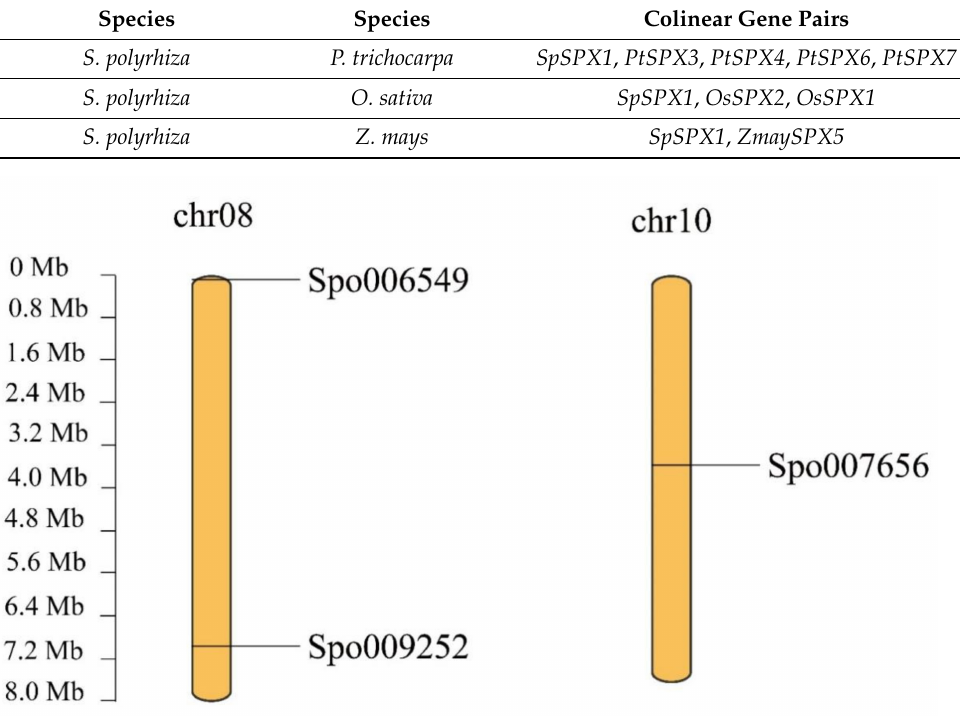
Figure 4. Distribution and synteny relationship of SpSPX genes on the chromosomes of S. polyrhiza . The chromosomes were indicated by orange color. SpSPX1 (Spo006549) and SpSPX3 (Spo009252) were located at chromosome 08 (chr08), and SpSPX2 (Spo007656) was located at chromosome 10 (chr10). Scale bar indicated chromosome length